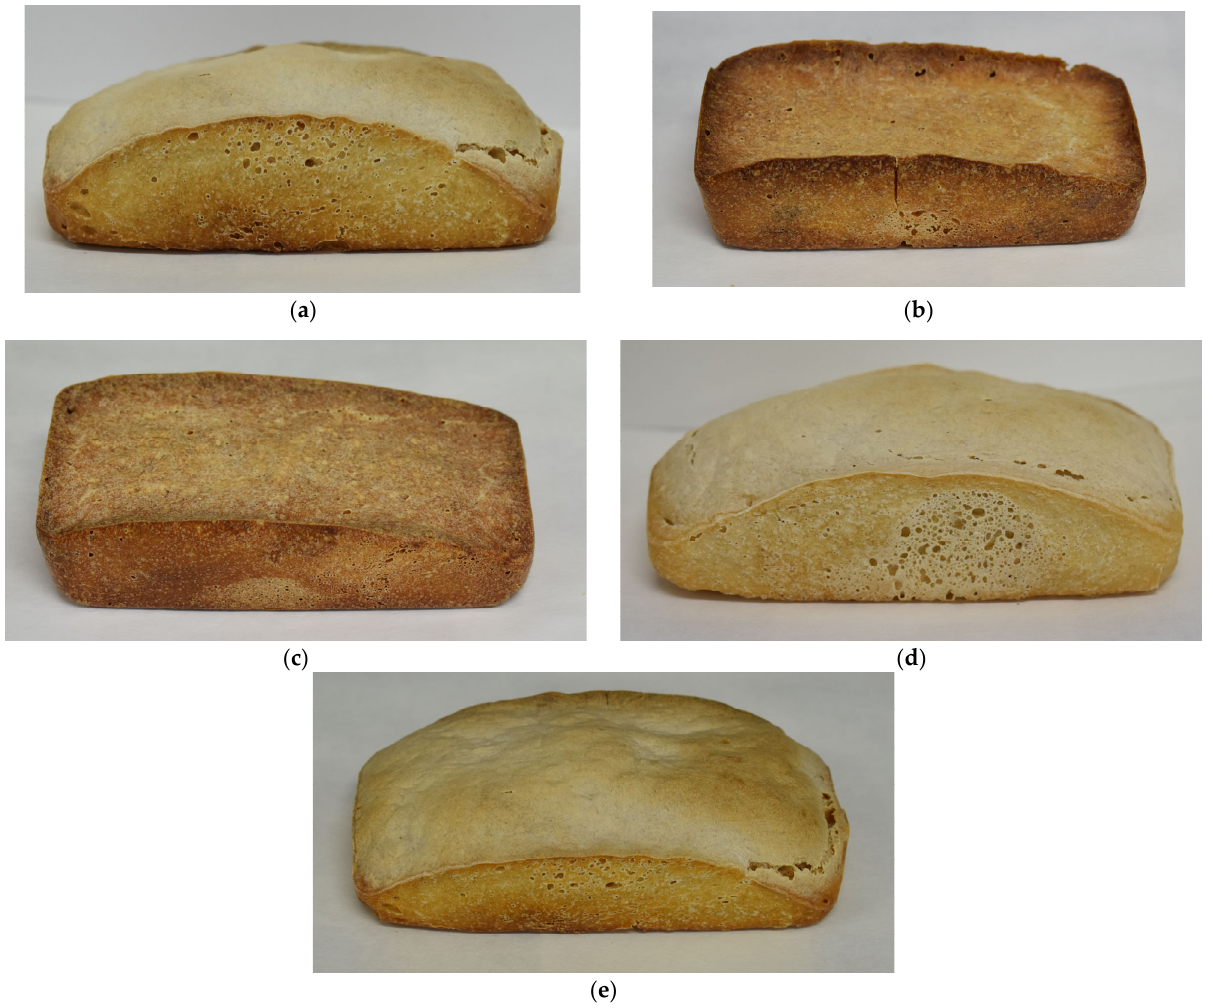
Figure 2. Images of the breads after baking. ( a ): bread control; ( b ): sourdough bread control; ( c ): sourdough bread control with propionate; ( d ): sourdough bread with L. plantarum 5L1 inoculum (0.5%); ( e ): sourdough bread with L. plantarum 5L1 inoculum (5%).